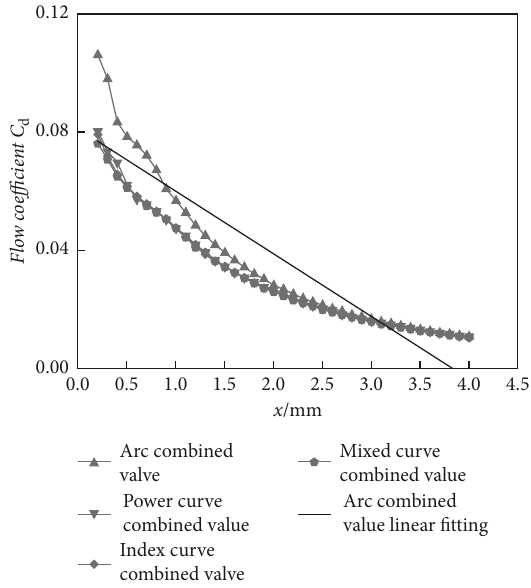
Figure 6: Flow coefficient of four valves.